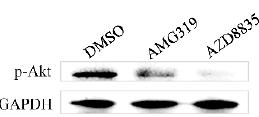
Figure 5. Detection of p-Akt by western blotting at 24 hpi in BmE cells that were infected with BmNPV-GFP at MOI 1 and administered 10 µM of each drug.